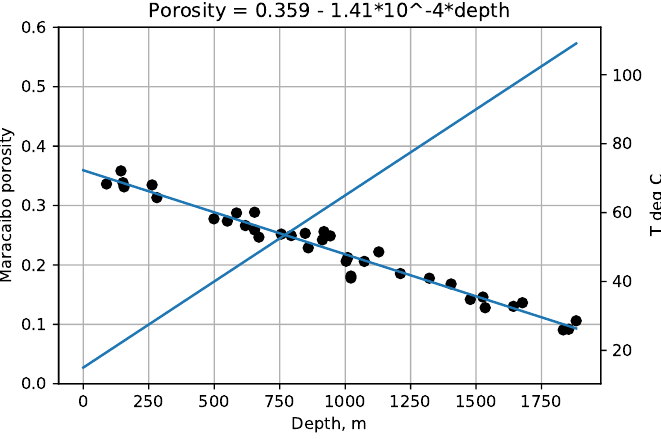
Figure 6. Maracaibo porosity trend.